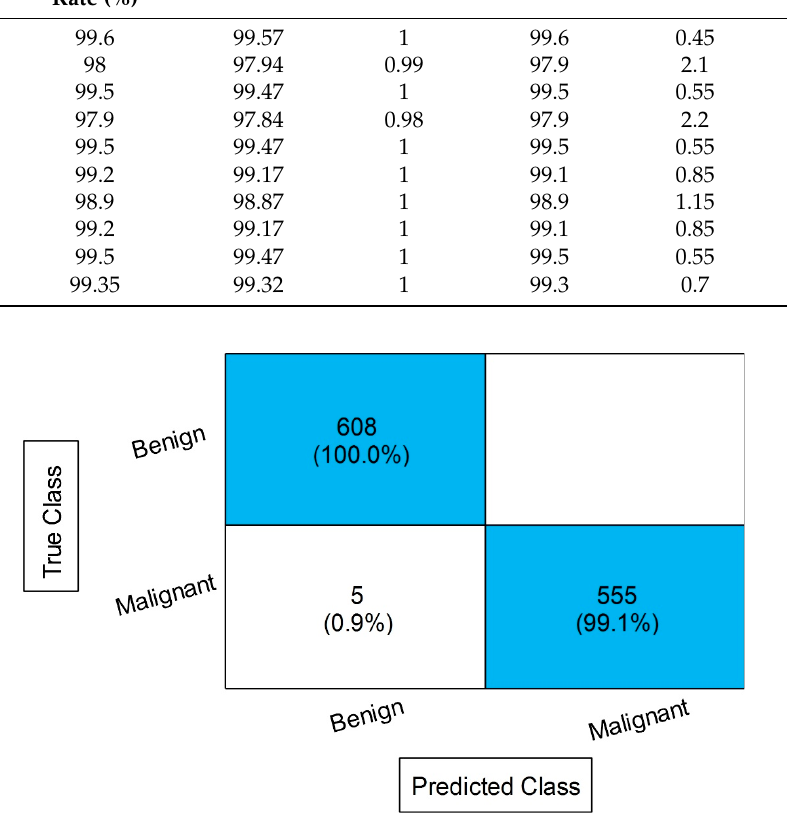
Table 8. Classification results of proposed feature fusion on INbreast dataset. Table 8. Classi fi cation results of proposed feature fusion on INbreast dataset.